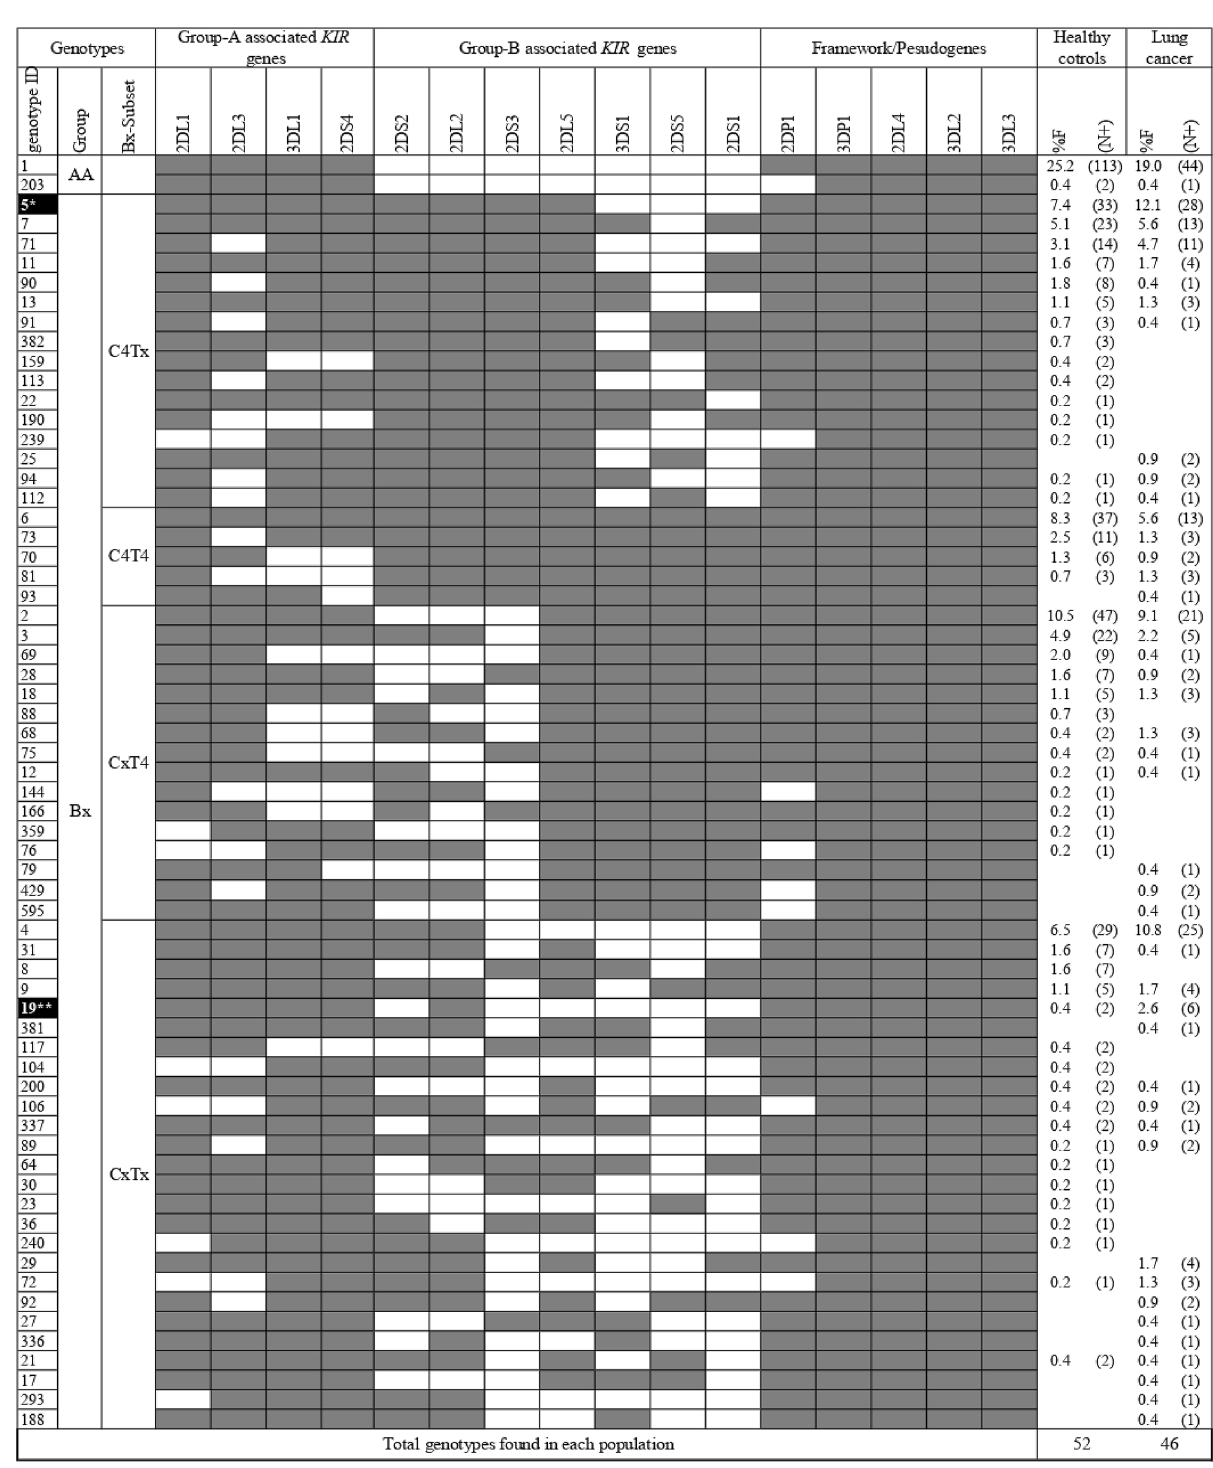
Figure 1. KIR gene content diversity among patients with lung cancer and healthy controls. N+ : number of individuals positive for the gene; n: number of individuals tested for the gene; Gene content of 65 KIR genotypes are displayed by presence/shaded boxes or absence/white boxes of 16 KIR genes. Distribution of genotypes with ID5, and ID19 highlighted by dark boxes were found to be significantly different between lung cancer patients and controls. * p = 0.048, OR 1.73, 95% CI: (1.015–2.93); ** p = 0.021, OR 5.92, 95% CI: (1.18–